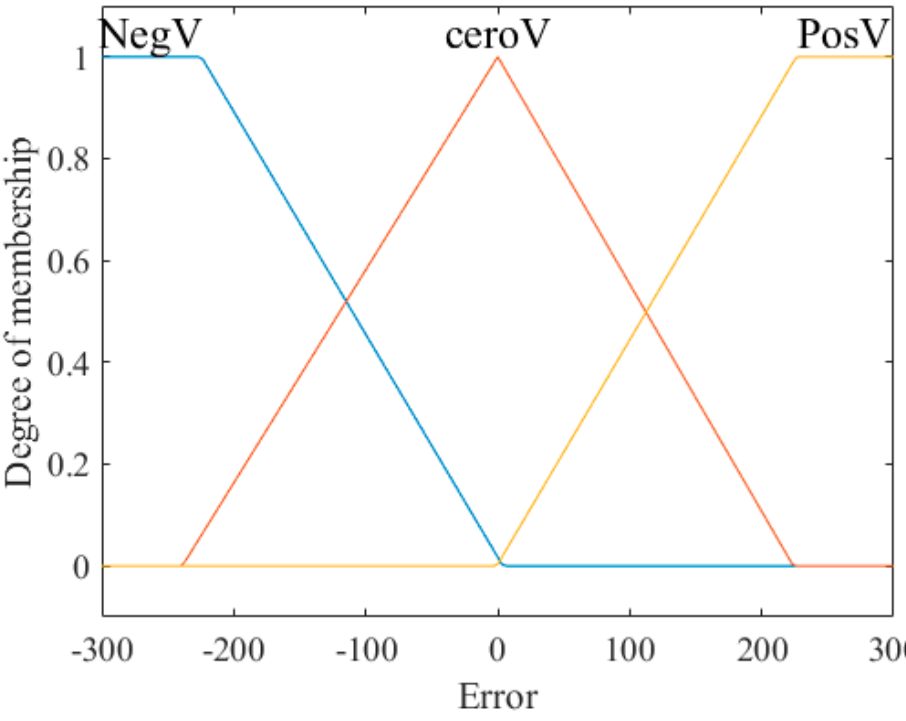
Figure 11. Input 1 for the FLC with signal generator speed reference.